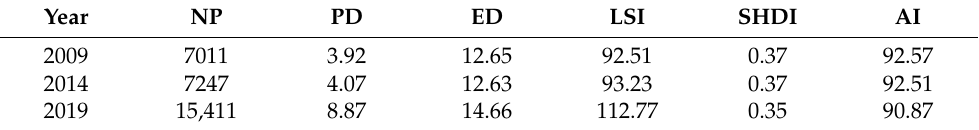
Table 8. Landscape pattern change of woodlands based on landscape-level indices in Anyuan County.